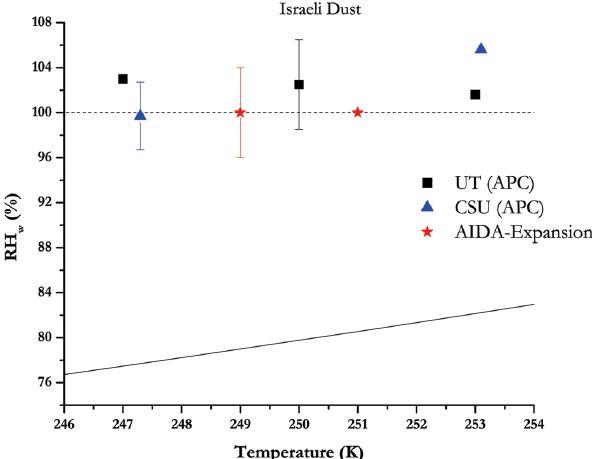
Fig. 6. Same as Fig. 4 but for Israeli Dust.